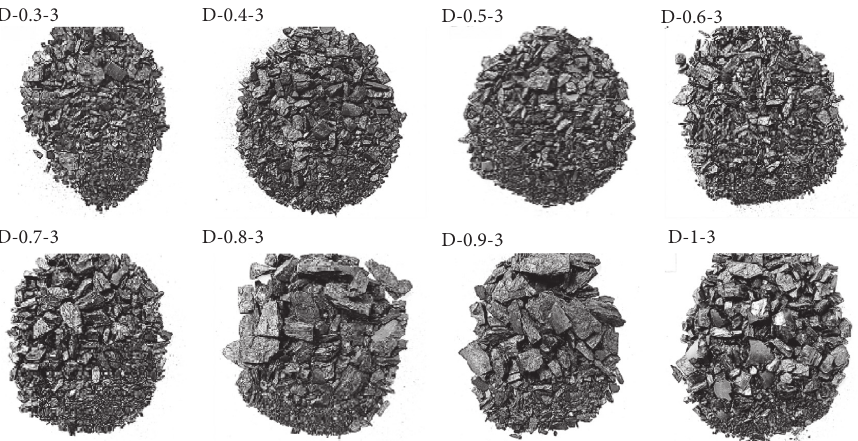
Figure 9: Failure modes of samples with different L / D